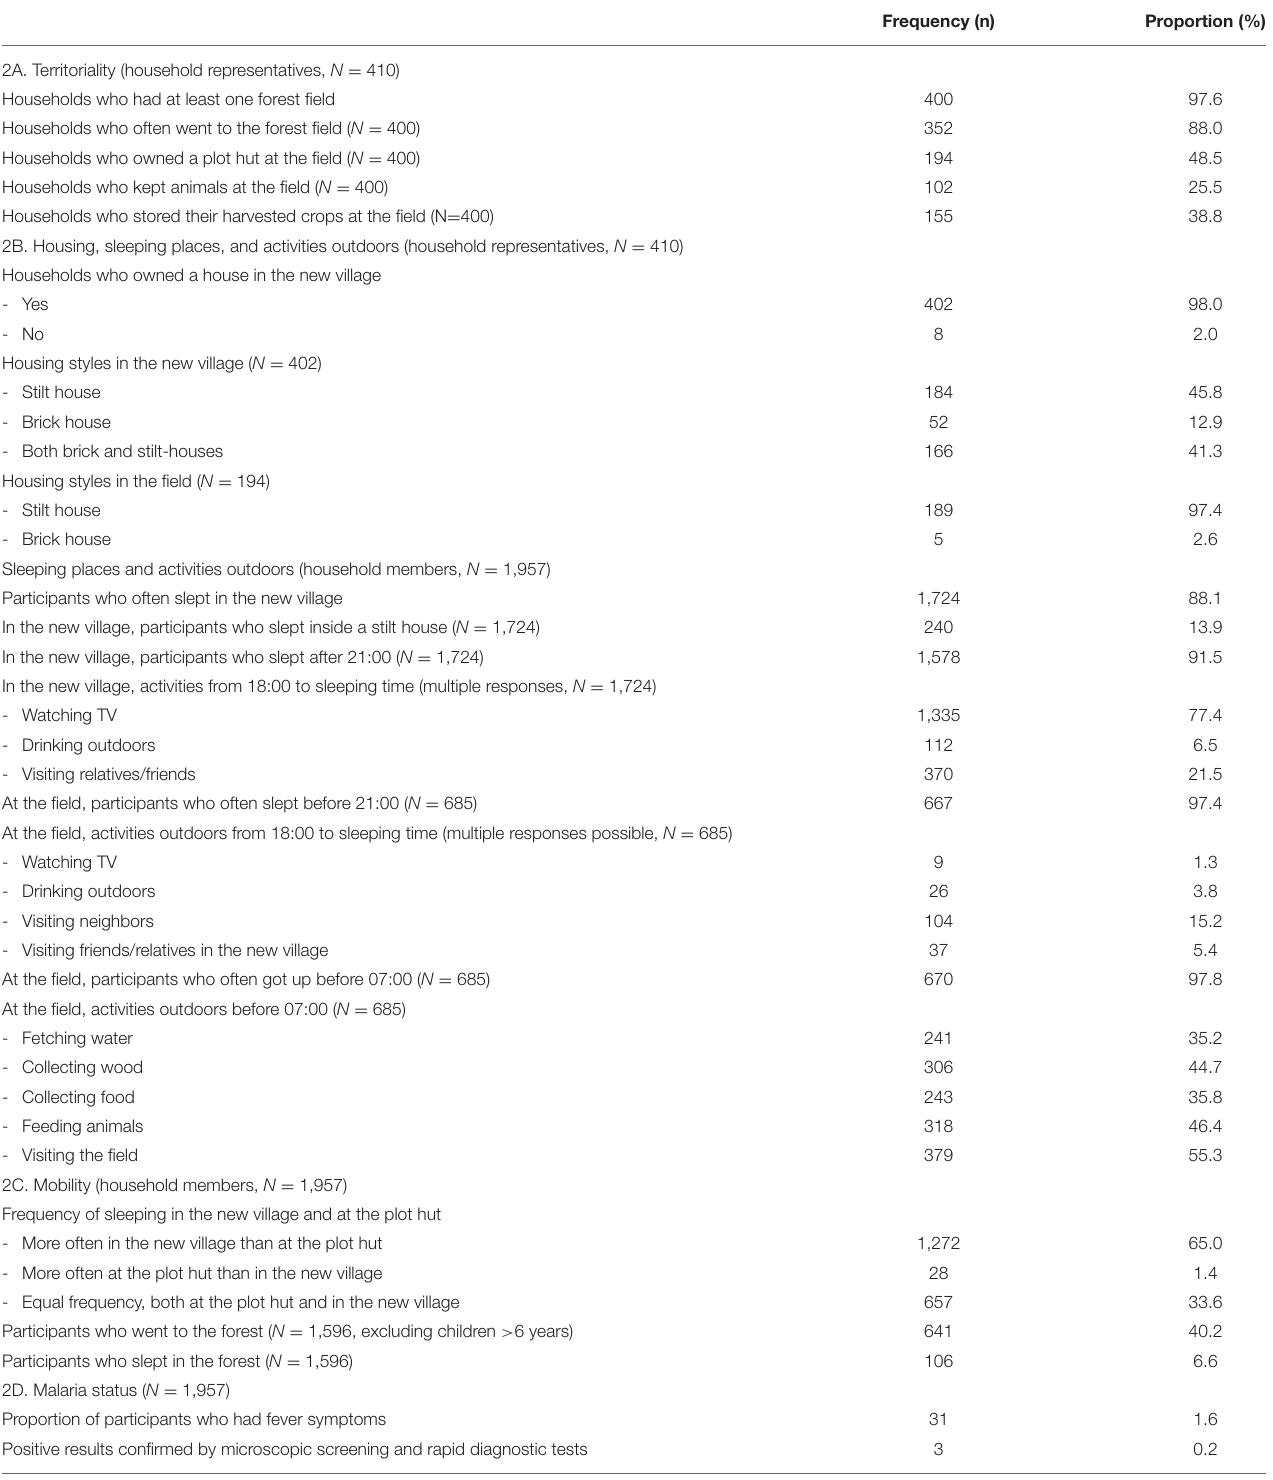
TABLE 2 | Territoriality, sleeping places, mobility, and malaria